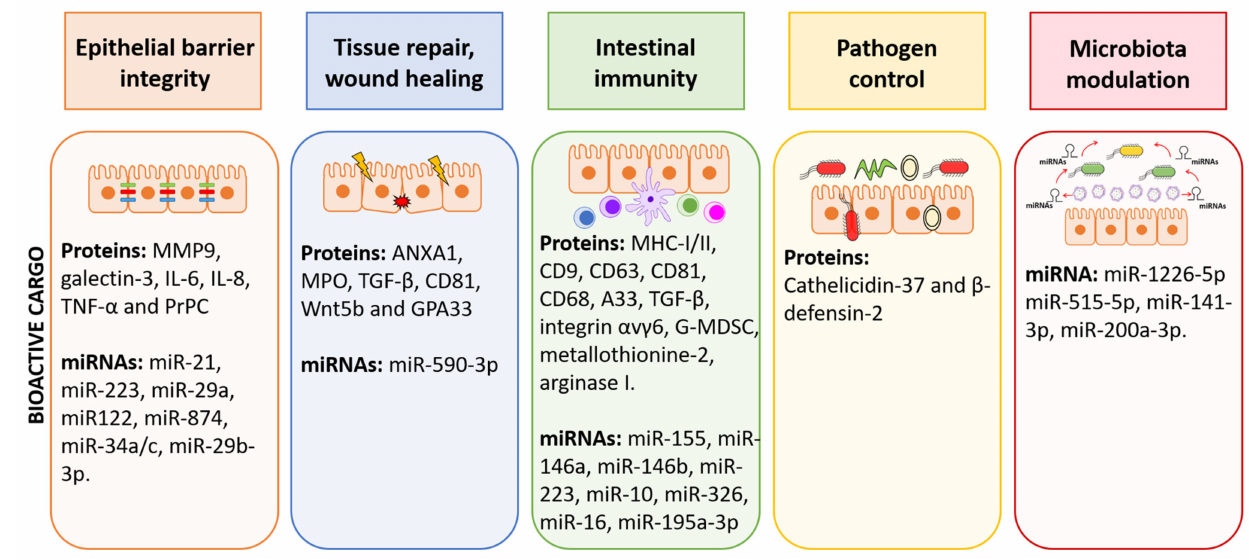
Figure 3. Graphical summary of functions of EVs within the gut environment. EVs derived from IECs and immune cells of the lamina propria contribute to cell-to-cell communication in the gut and have great impact on the homeosta- sis/inflammation balance. The scheme summarized the bioactive cargo in EVs that can influence epithelial barrier integrity, tissue repair, immune responses, control of pathogens, and microbiota